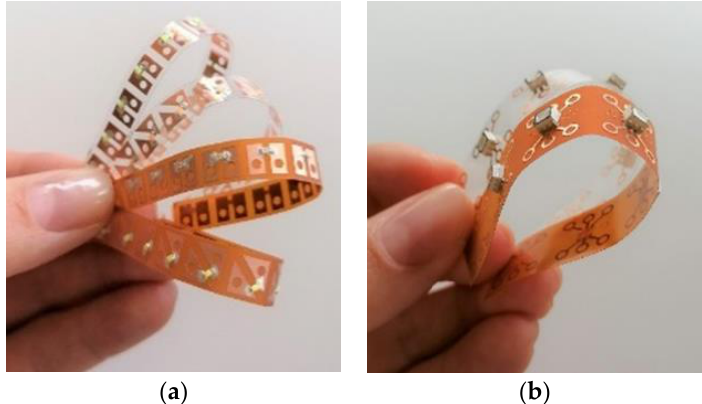
Figure 10. Printed sequin tapes: ( a ) LED sequin tapes and ( b ) RGB sequin